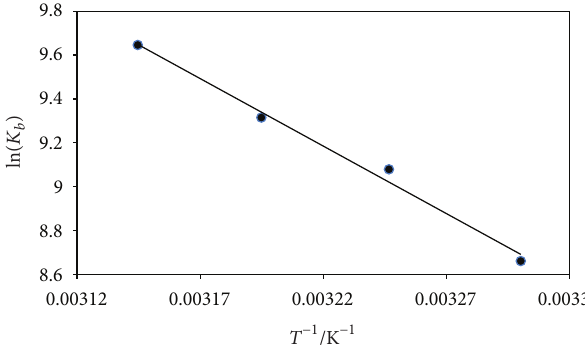
F 3: e van’t Hoff plot of CPT-11 to ds-DNA. All of conditions are similar to Figure 1.